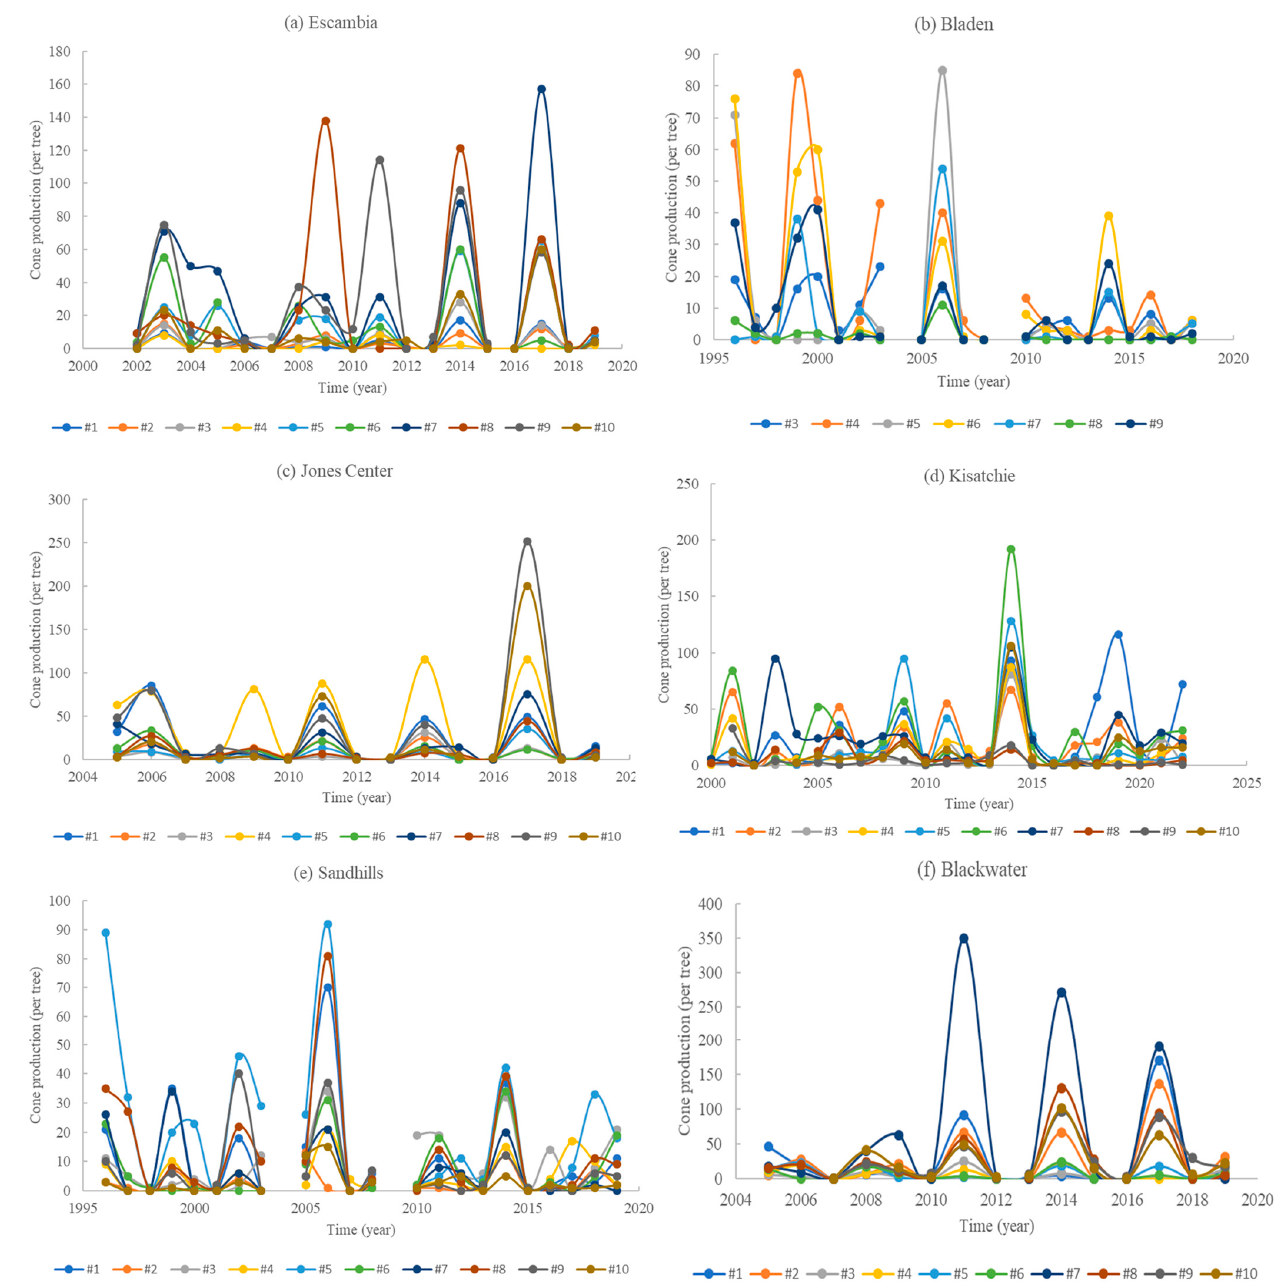
Figure 1. Cycles of cone production of individual trees at different sites (#1, 2…10 represent 10 sampled trees).